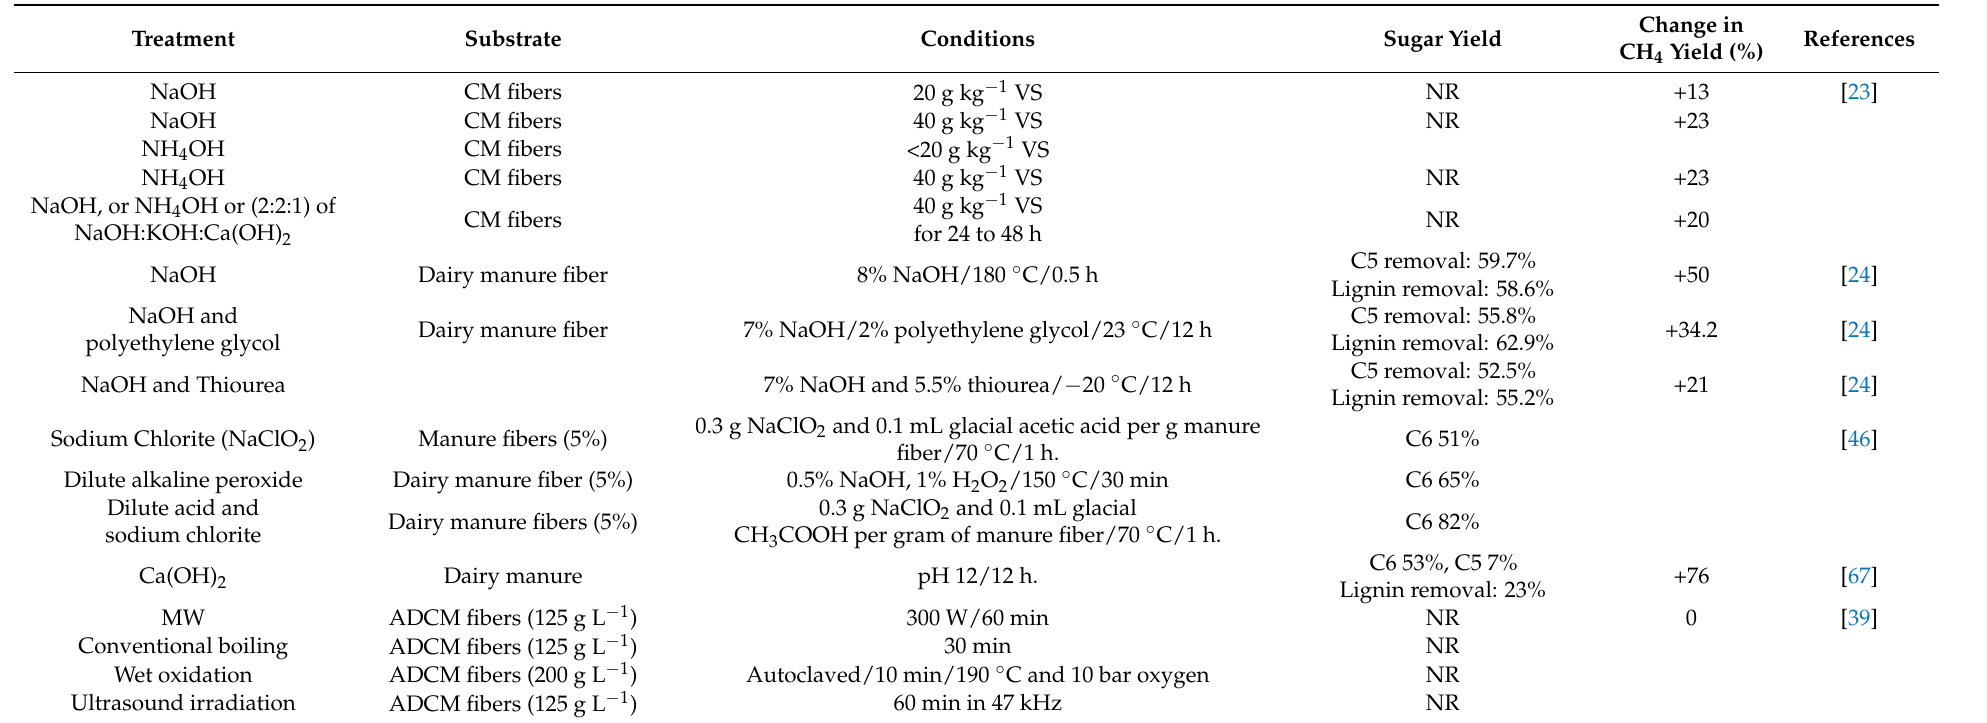
Table 4. Performance of different procedures for alkaline and other treatments for hydrolysis of dairy